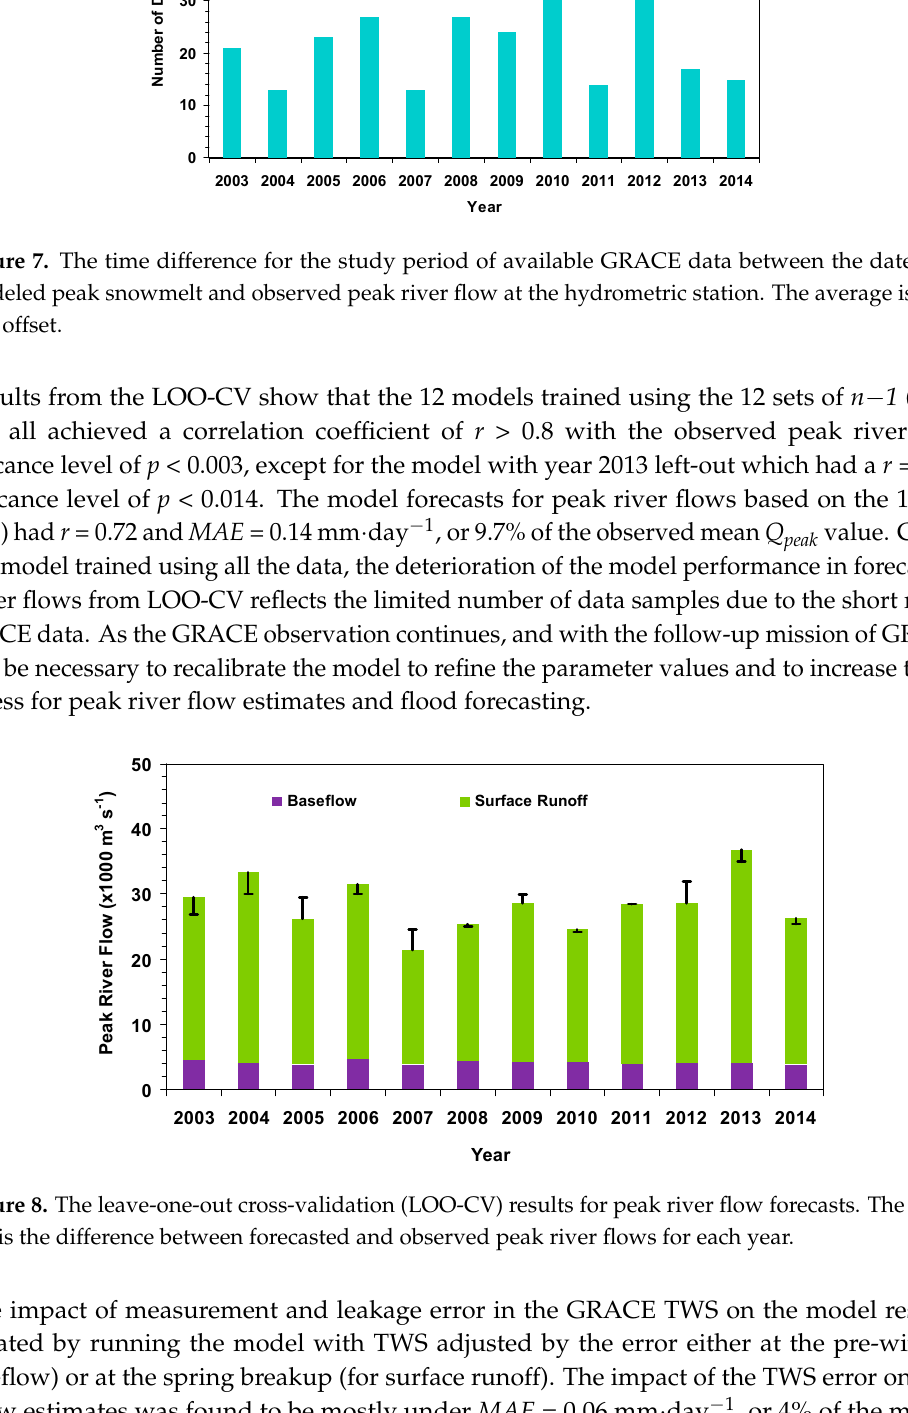
Figure 7. The time difference for the study period of available GRACE data between the dates for modeled peak snowmelt and observed peak river flow at the hydrometric station. The average is a 22 day offset.